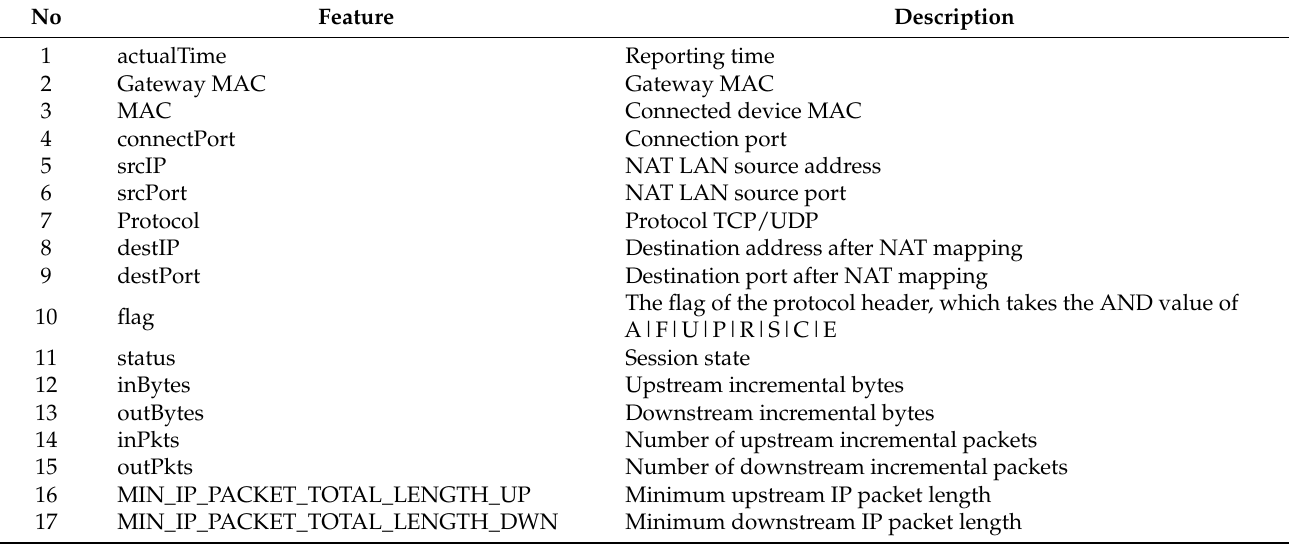
Table 1. Traffic features for attack